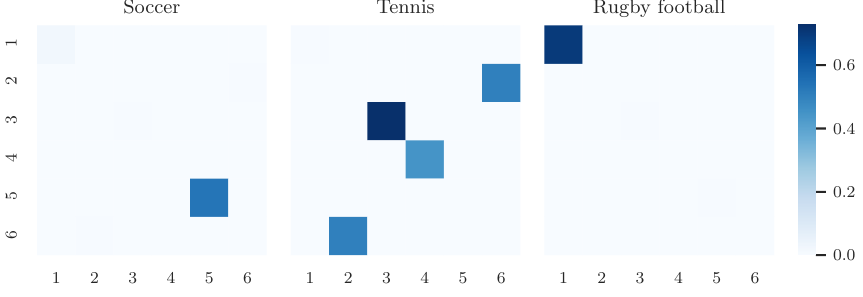
Figure A7. Colored heatmap of affinity tensor R